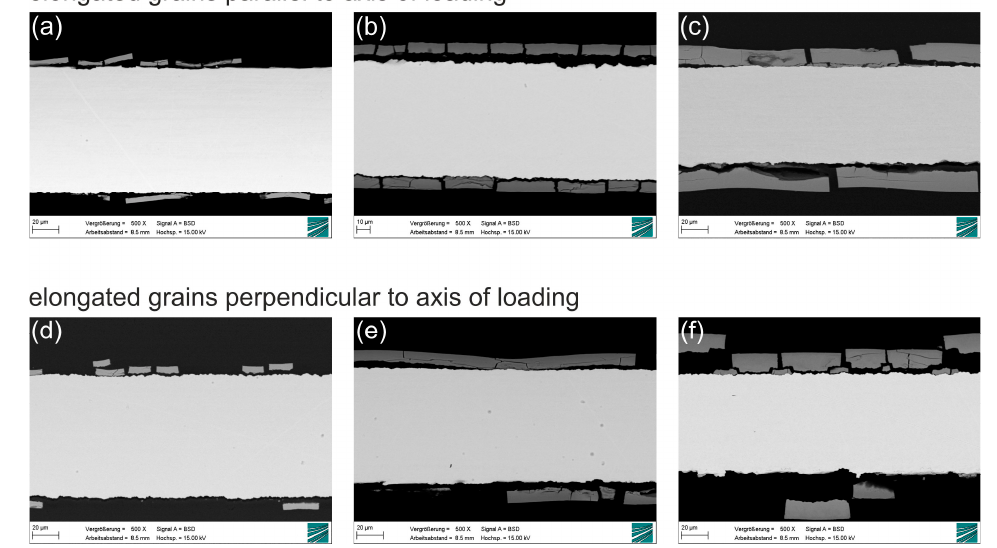
Figure 5. SEM images of molybdenum sheet metal after immersion for 2–6 months in Kokubo’s SBF. Images ( a – c ) show the sheet metal samples with elongated grains parallel to the axis of loading in tensile testing. Images ( d – f ) show the sheet metal samples with elongated grains perpendicular to the axis of loading (see Figure 11 in Section 4).